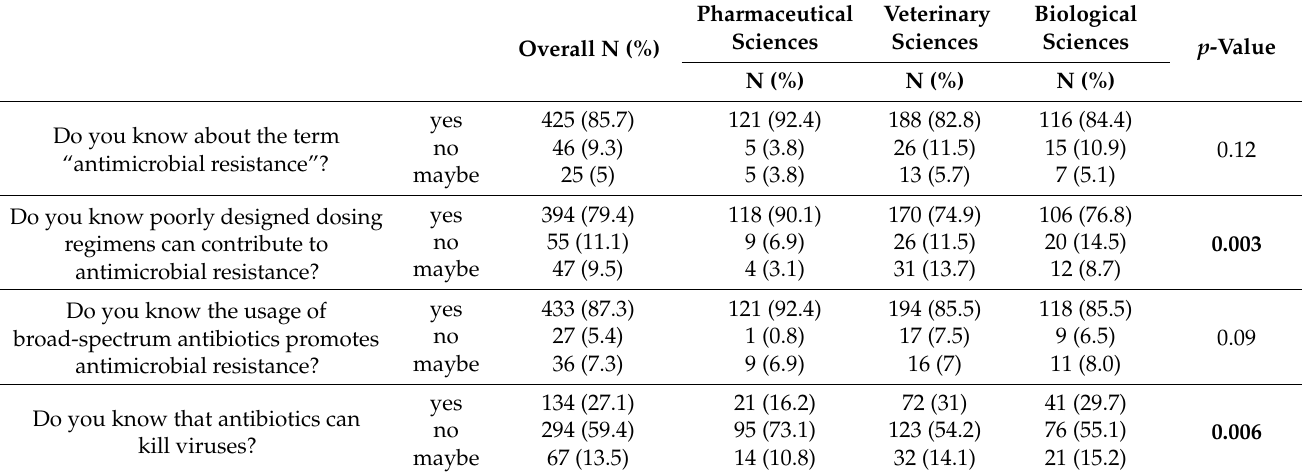
Table 2. Participant’s knowledge about antimicrobial